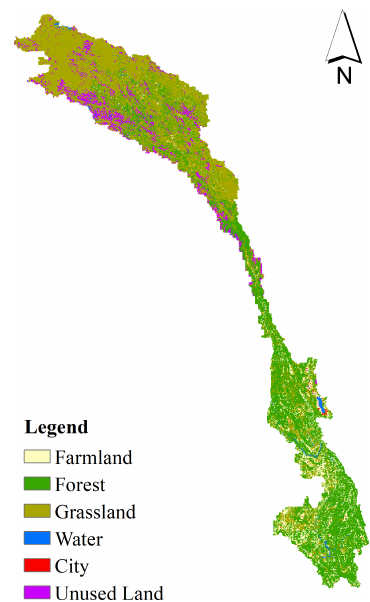
Figure 16. Land use classification in the LR basin in